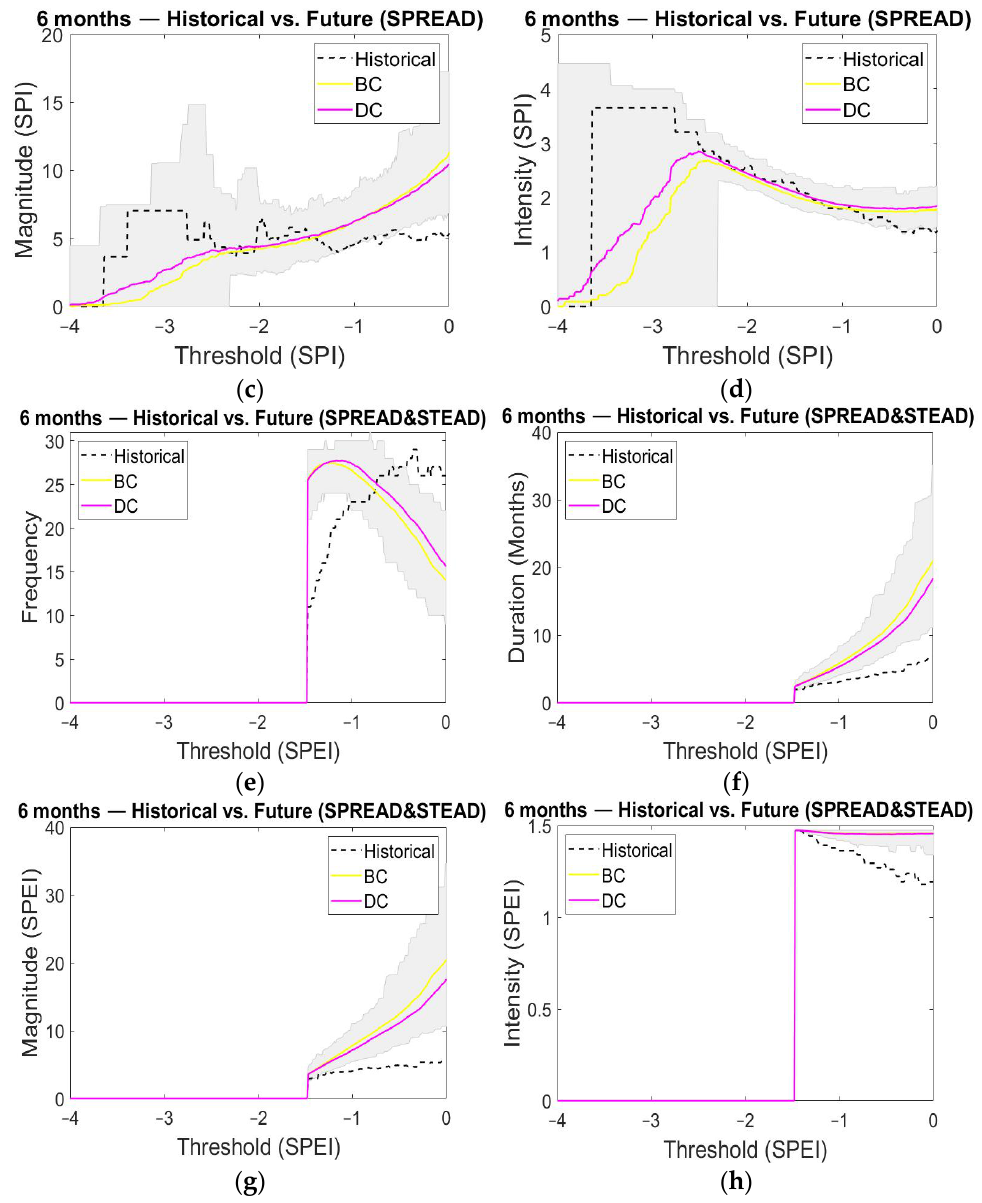
Figure A3. Historical and future meteorological drought ( a ) frequency; ( b ) mean duration; ( c ) mean magnitude; ( d ) mean intensity derived from SPI for the 6 months temporal-aggregation scale (SPREAD and STEAD database). Historical and future meteorological drought ( e ) frequency; ( f ) mean duration; ( g ) mean magnitude; ( h ) mean intensity derived from SPEI for the 6 months temporal-aggregation scale (SPREAD and STEAD database).